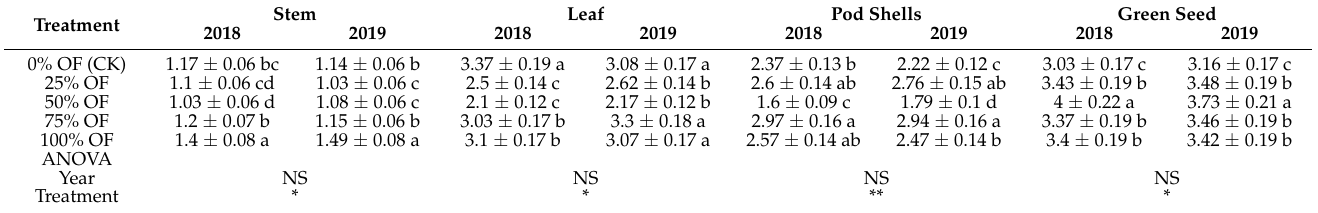
Table 6. Nitrogen contents in different plant components at harvest of green seeds for different treatments (%).